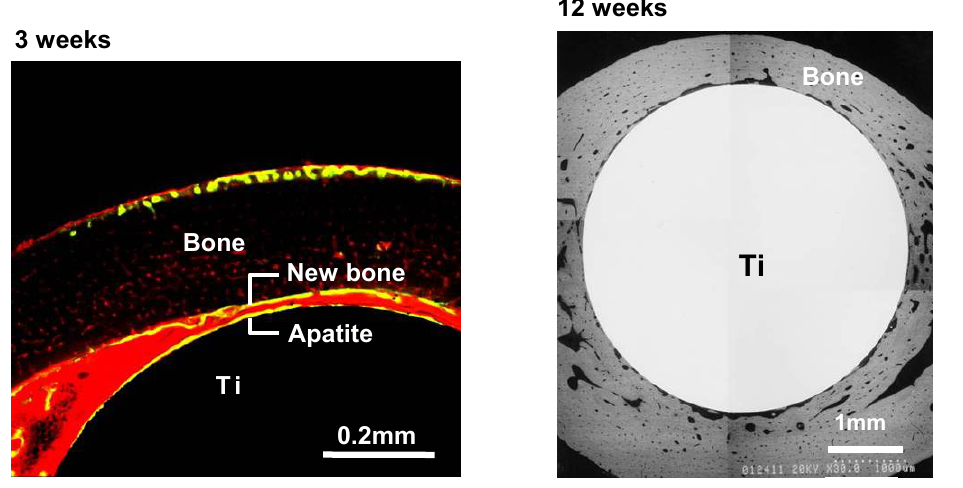
Figure 11. Confocal laser scanning microscopy photograph (left-hand side) and SEM photograph (right-hand side) of the cross-section of the NaOH- and heat-treated Ti metal implanted into rabbit femur for three and 12 weeks, respectively.